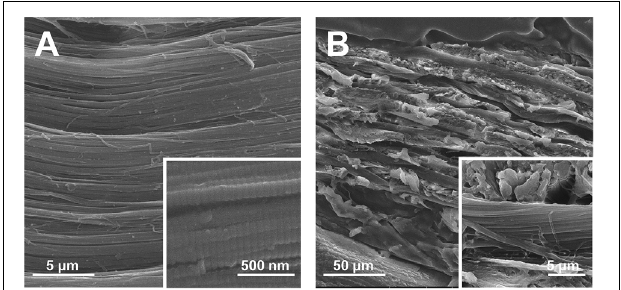
FIGURE 3 | SEM images of ACL. (A) The surface and (B) longitudinal section